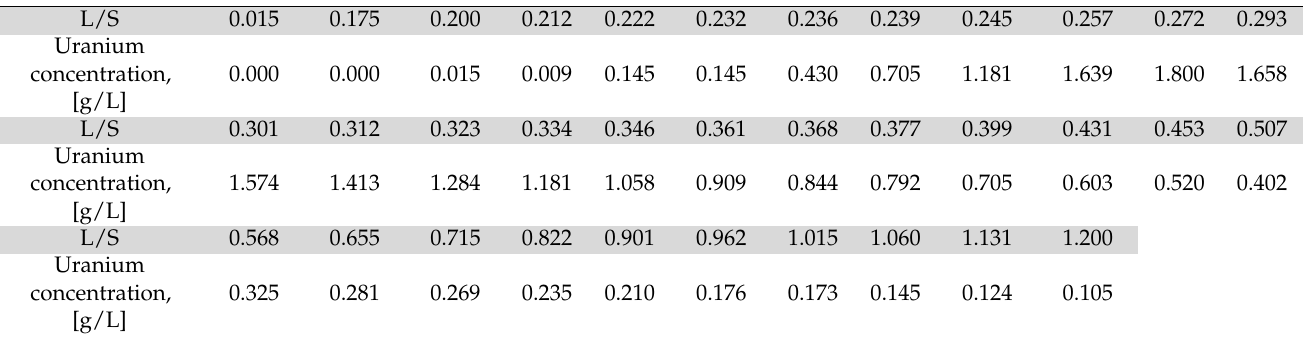
Table A1. Experimental data on dissolved uranium concentration at the tube outlet (Experiment 1: H 2 SO 4 = 30 g/L).